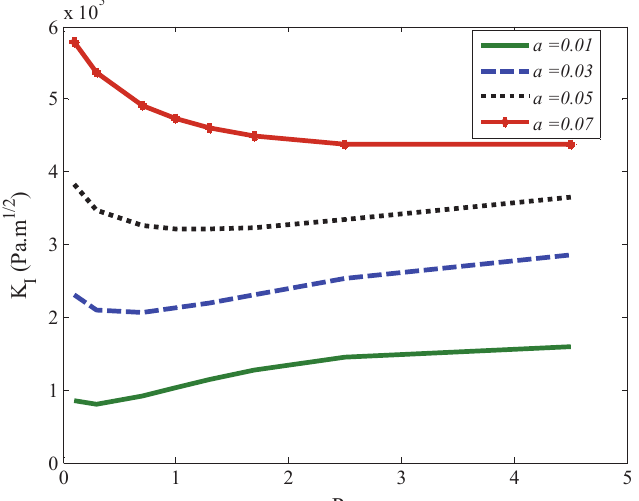
Figure 8: SIF vs. P curves for different values of circumferential crack length.